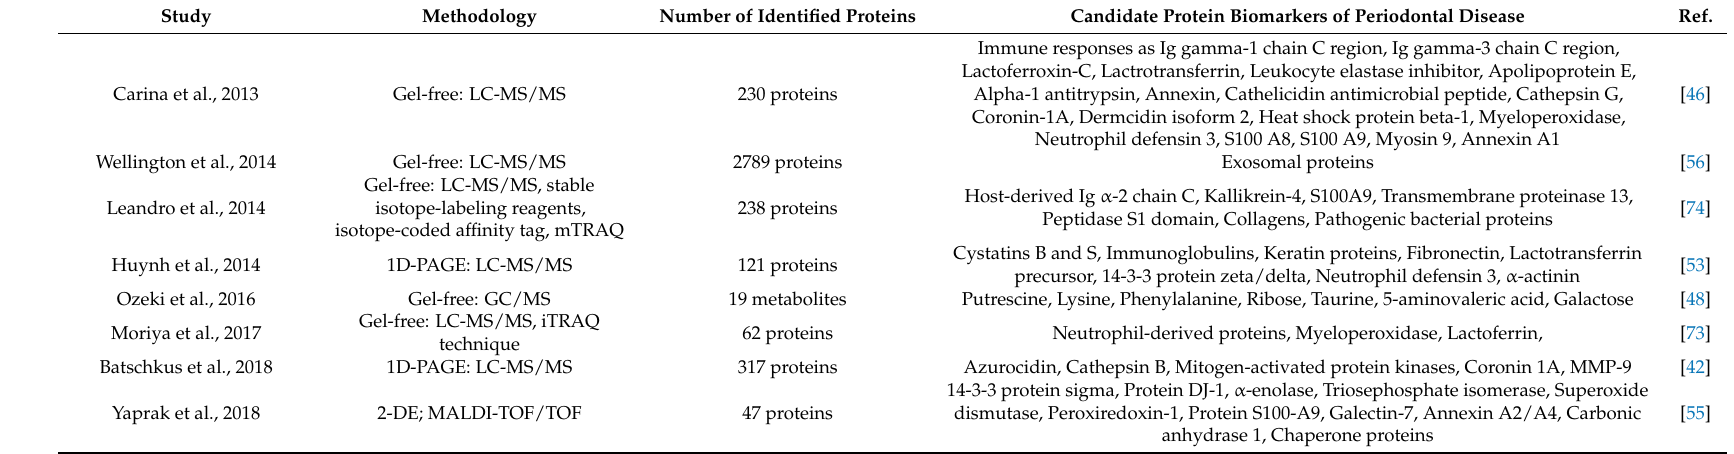
Table 1. Application of proteomic technologies to discover and identify prospective biomarkers for periodontal diseases in gingival crevicular